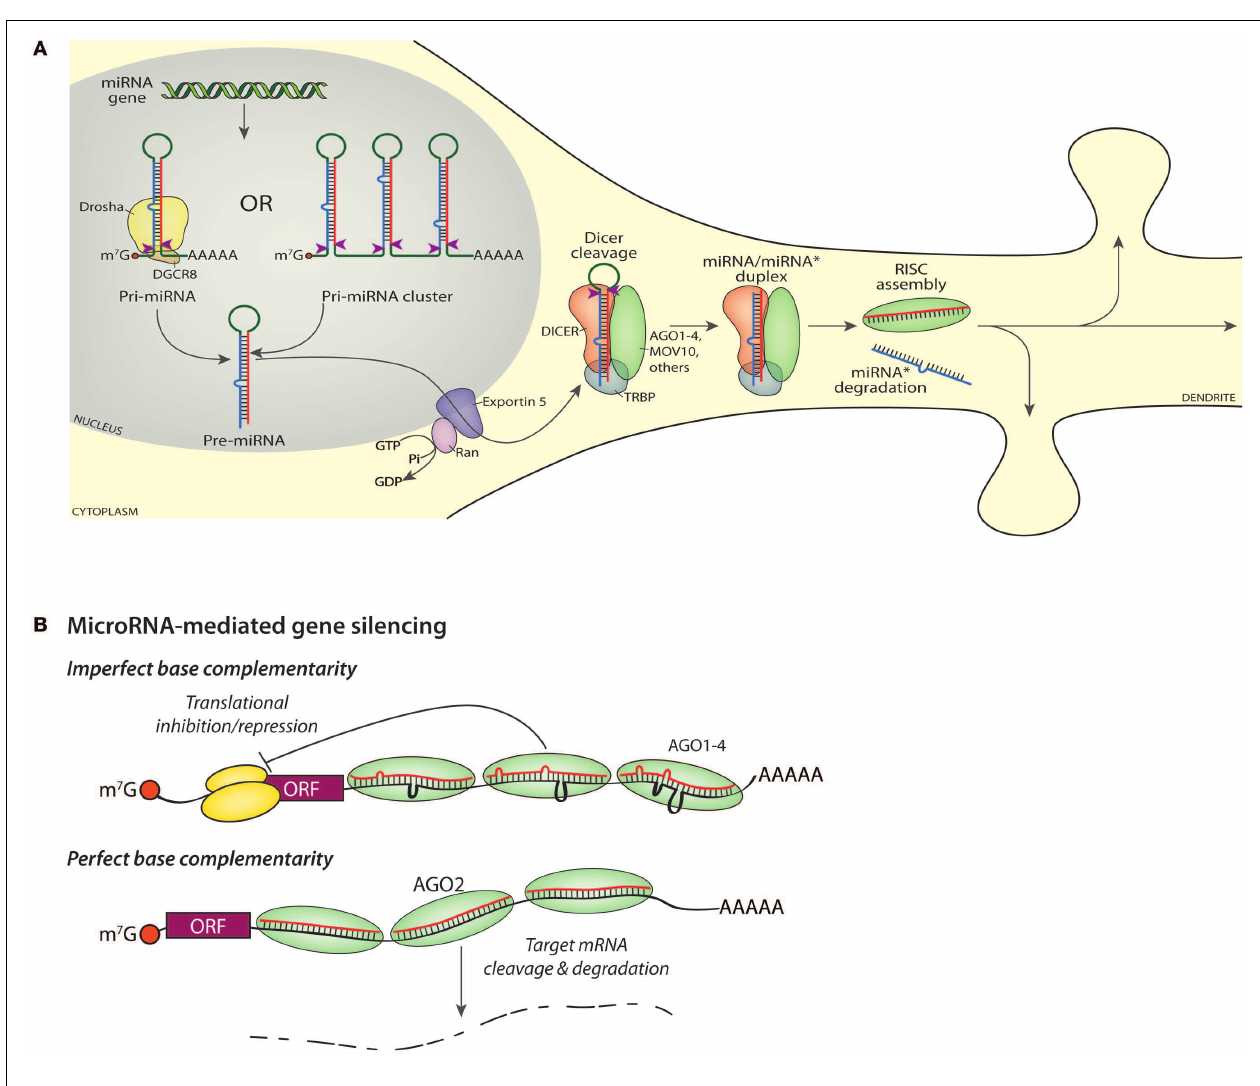
FIGURE 2 | miRNA biogenesis and gene silencing. (A) Transcription of a miRNA gene yields a capped, polyadenylated Pri-miRNA shown undergoing cleavage (red arrowheads) by Drosha (top, left).Transcription of a miRNA cluster yields a transcript encoding multiple miRNAs (top, right), each of which must be cleaved into a Pre-miRNA by Drosha.The mature or “guide” miRNA is shown in red, with the “star” or “passenger” strand shown in blue. Nuclear export of the Pre-miRNA requires Exportin-5. Cleavage of the Pre-miRNA by DICER (red arrowheads) generates a mature guide and star strand duplex; cleavage occurs in a protein complex that includes DICER, an Argonaute protein (AGO1-4), MOV10,TRBP, and additional proteins such as